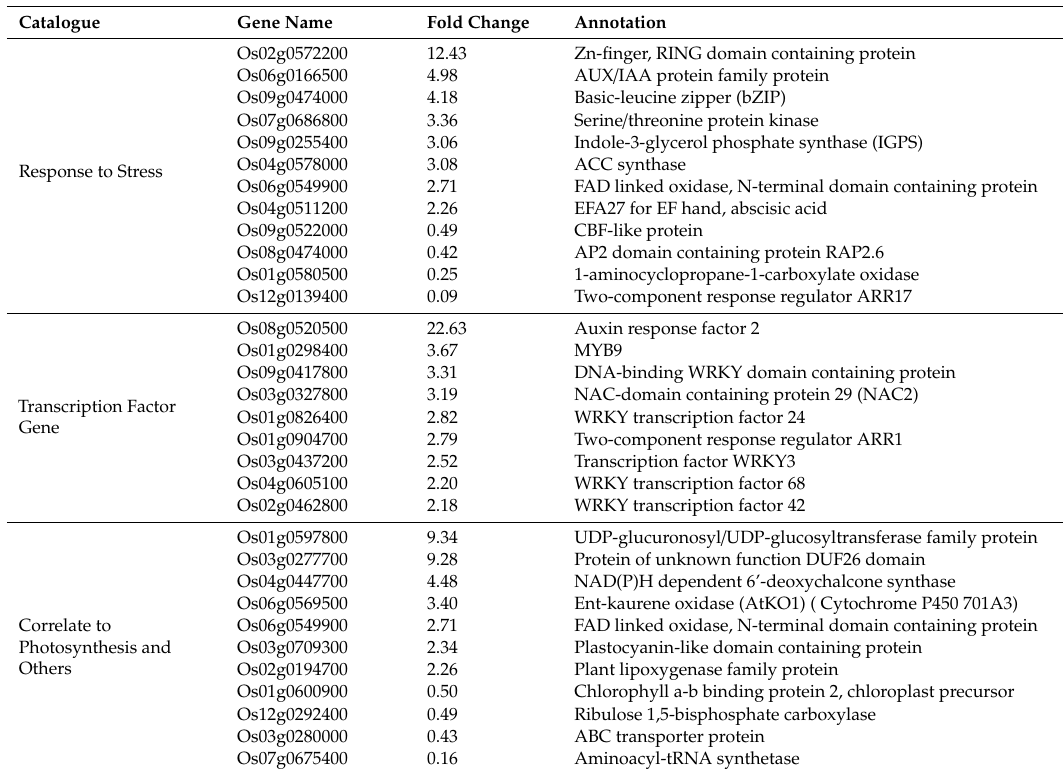
Table 3. Di ff erent expressing genes related to stress, transcription factor and others response to coronatine under drought